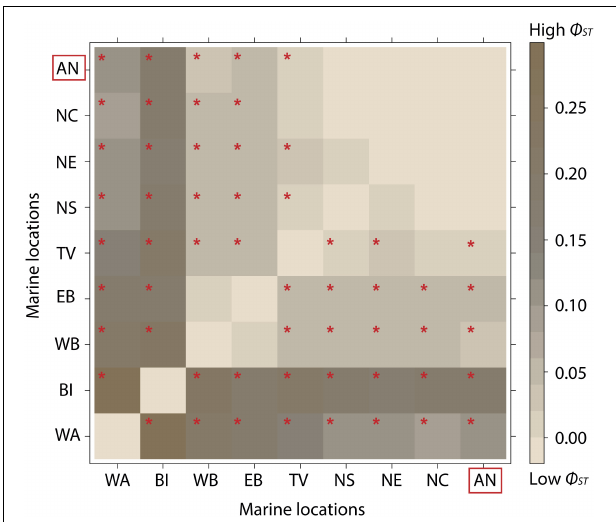
FIGURE 3 | Heatmap of differentiation pairwise ( (cid:56) ST ) between 10 marine locations of Atlantic cod: western Atlantic (WA), Baffin Island (BI), western Baltic (WB), eastern Baltic (EB), Tvedestrand fjord (TV), North Sea (NS), North East Arctic (NE), Norwegian coast (NC), and Ancient specimens (AN). Dark brown colors indicate higher levels of differentiation ( (cid:56) ST = 0.15–0.30). Light brown corresponds to lower levels of differentiation ( (cid:56) ST = ≥ 0.10). Significant p- values ( p ≤ 0.05) are indicated with a red * p- values are listed in Supplementary Tables 9, 10 .